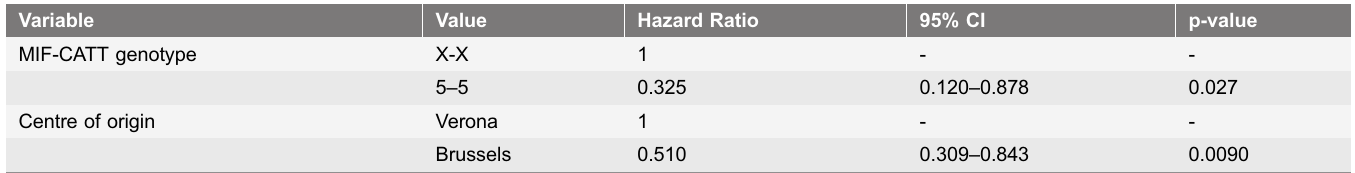
Table 3. Cox regression analysis for age at first acute episode with FEV1 , 60% of predicted value on 185 Cystic Fibrosis patients homozygous for the F508del